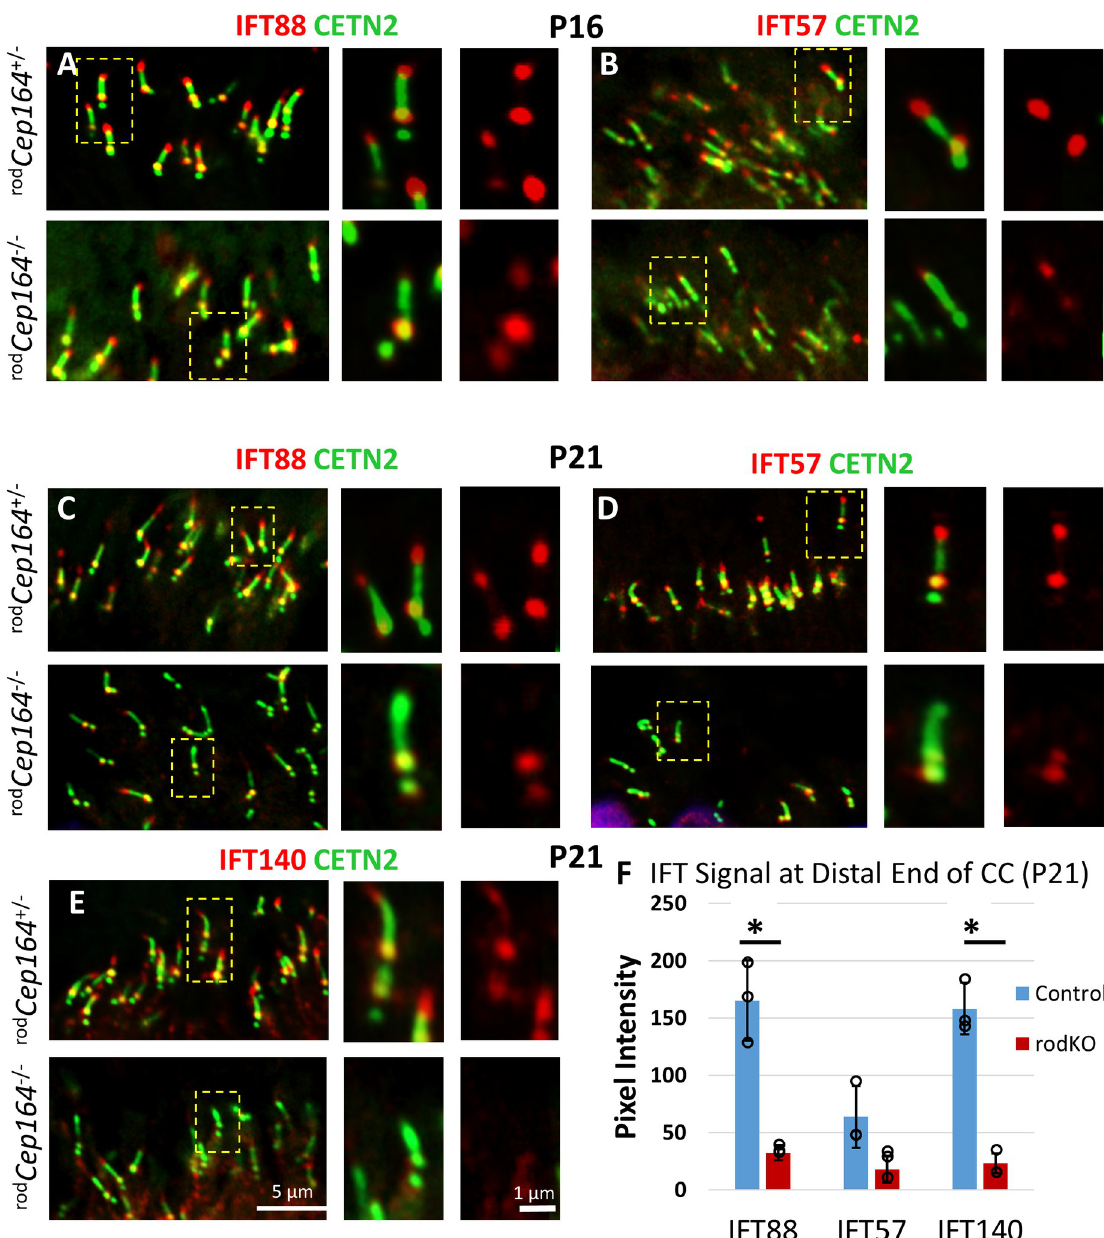
Fig 6. Loss of IFT88, IFT57 and IFT140 in rod Cep164 -/- photoreceptors. A, B, immunohistochemistry of rod Cep164 +/- (upper panels) and rod Cep164 -/- (lower panels) cryosections at P16 probed with anti-IFT88 (A) and anti-IFT57 (B) antibodies. C-E , immunohistochemistry of P21 rod Cep164 +/- (upper panels) and rod Cep164 -/- (lower panels) cryosections probed with anti-IFT88 (C), anti-IFT57 (D) and anti IFT140 (E). Insets to the right of main panels show enlargements of individual representative BB/CC structures as indicated by hatched rectangles (left panels) or antibody alone (red). F , red channel pixel intensity of IFT88, IFT57 and IFT140 signal at CC distal end at P21 using 3 animals each. The IFT57 signal was not significant, likely due to higher variance in the